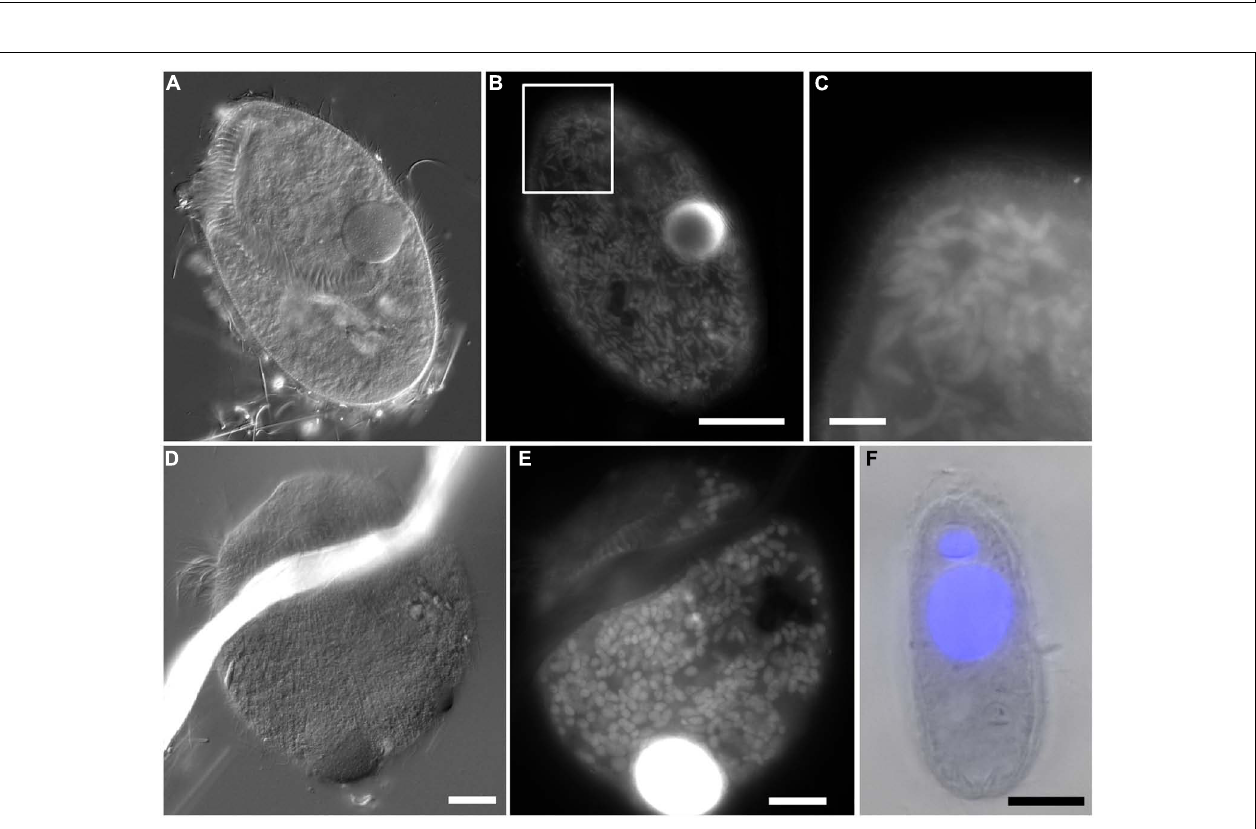
FIGURE 4 | Light micrographs. (A,B) Thecate foraminifer from 611 c3 (L’Atalante control), paired images showing DIC (A) and epifluorescence (B) of DAPI staining. Note the nucleus and lack of associated prokaryotes (B) in the well-vacuolated cytoplasm (A) . This specimen was considered living at the time of fixation. (C,D) protist